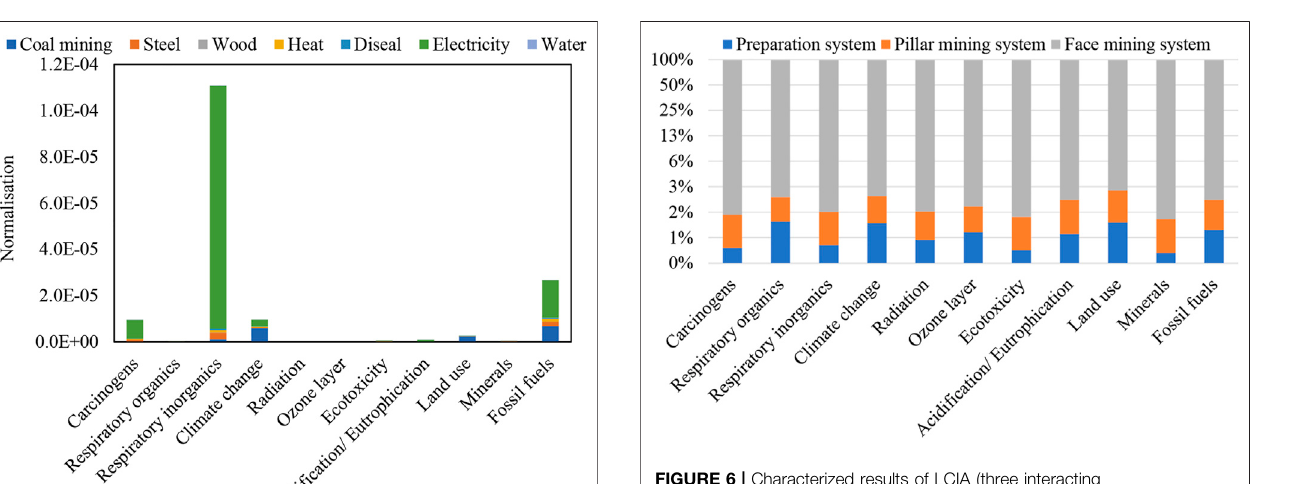
FIGURE 6 | Characterized results of LCIA (three interacting